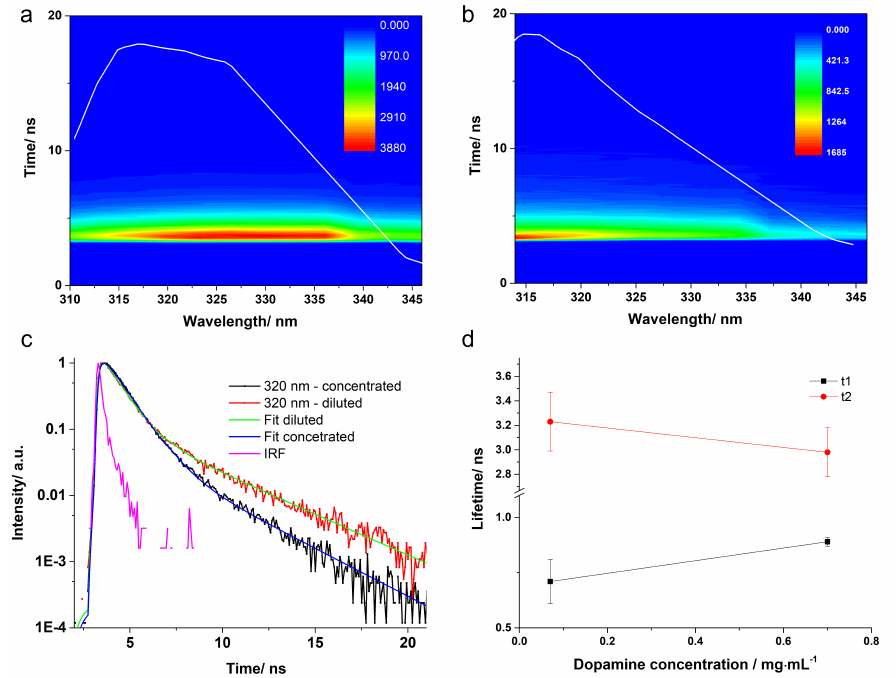
Figure 6. Time-correlated single-photon counting (TCSPC) 3D data carpet obtained from the concen- trated ( a ), respectively diluted ( b ) DA solution at pH = 8 following excitation at 280 nm. The white line represents the integrated fluorescence spectrum. Normalized kinetic traces recorded at 320 nm with the fitted curves ( c ). The average lifetimes obtained for each solution ( d